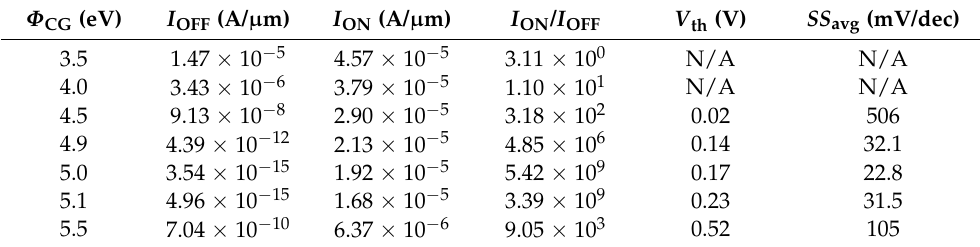
Figure 10. ( a ) Energy band profiles along A–A’ and B–B’ in the OFF-state; ( b ) electric field profiles along A–A’ and B–B’ in the OFF-state; ( c ) energy band profiles along A–A’ and electric field profiles along B–B’, in the ON-state; and ( d ) electric field profiles along C–C’ in the ON-state, for DGNP- EHBTFET with Φ CG = 3.5~5.5 eV. Table 4. Extracted parameters from transfer characteristic curves at Φ CG = 3.5 ~ 5.5 eV.